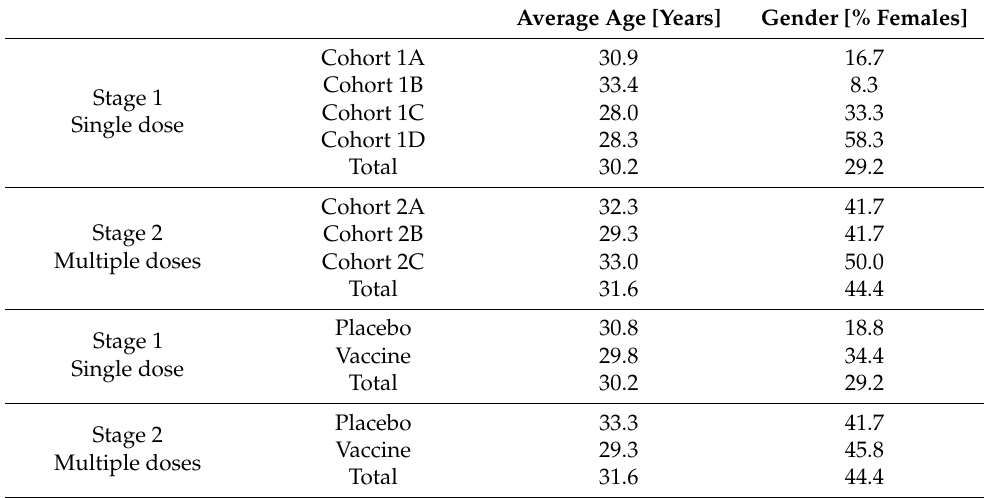
Table 1. Age and gender distribution by cohort and group